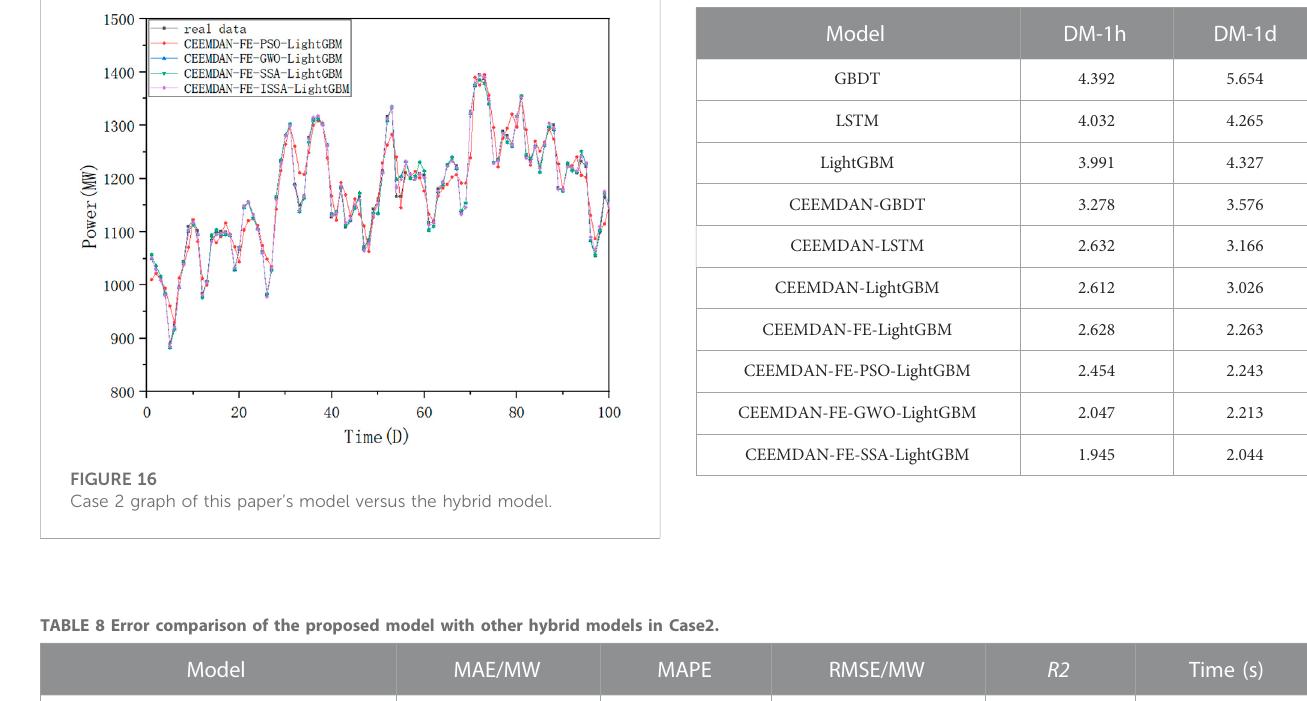
TABLE 9 Error comparison of the proposed model with other hybrid models.